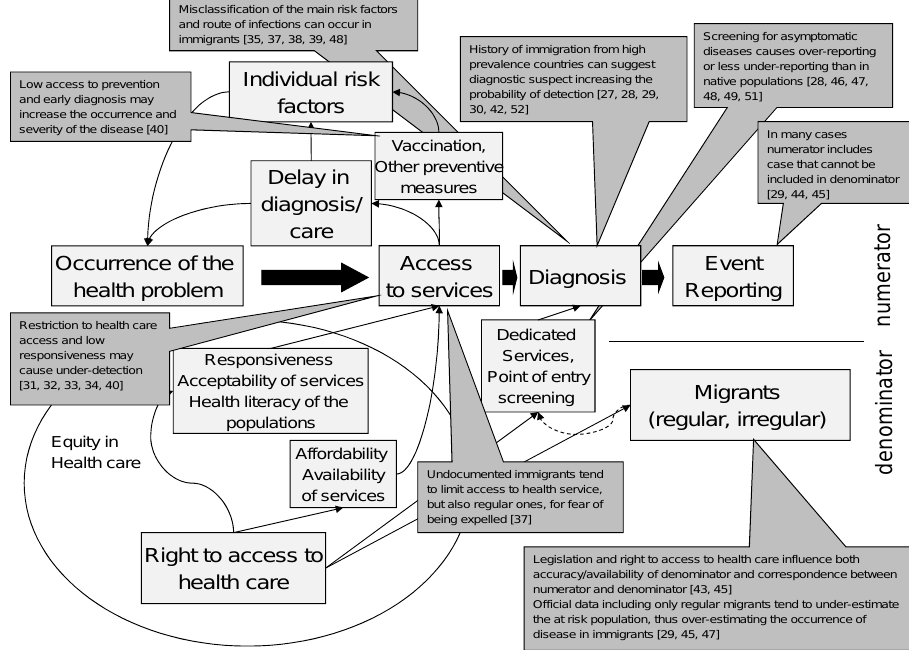
Figure 2. Results of the scoping review reported on the conceptual framework of the interaction between migrant access to health care and indicators to monitor infectious diseases. In the middle the theoretical flow from occurrence of the disease to reporting the event in a surveillance system is represented. Black arrows represent the causal effects of factors that could influence the accuracy of infectious disease surveillance in immigrants. The grey boxes report the results of the literature